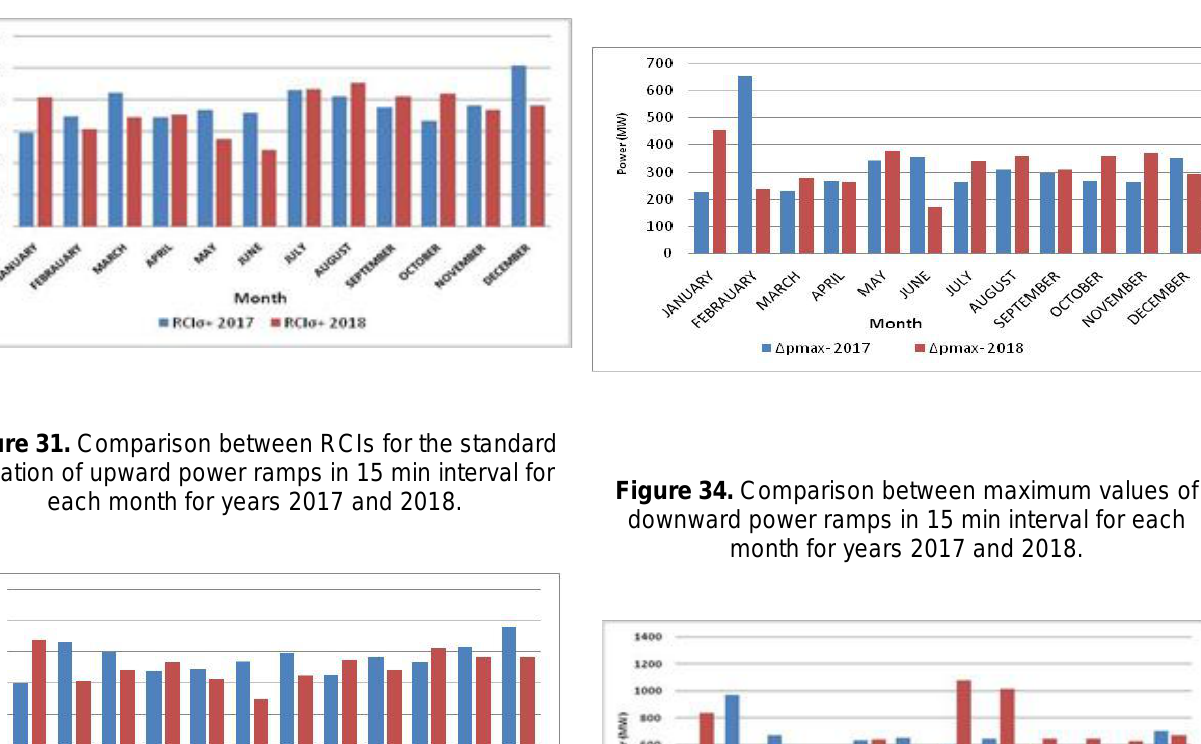
Figure 33. Comparison between maximum values of upward power ramps in 15 min interval for each month for years 2017 and 2018.